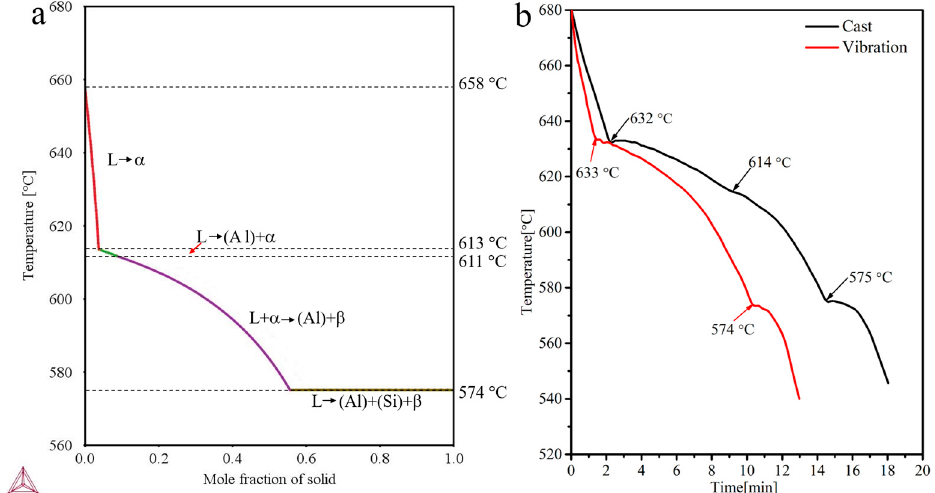
Figure 4. The solidification sequence of Al-7Si-3Fe based on Thermal-Calc software ( a ) and cooling curves of as-cast and as-vibration Al-7Si-3Fe alloys measured by experiment ( b ).